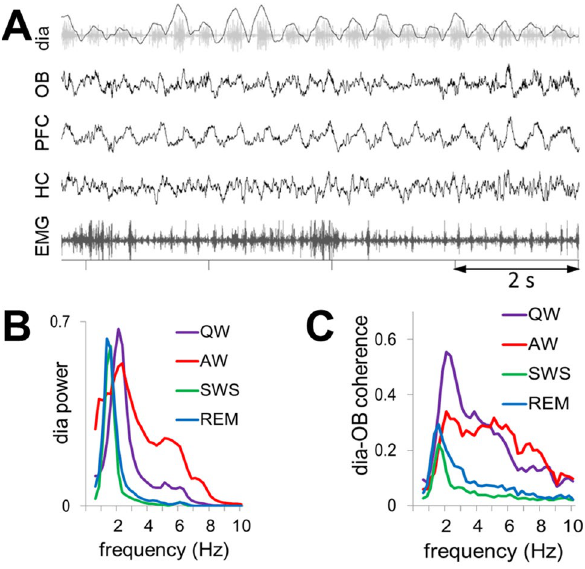
Figure 1. ( A) Sample recording of respiratory rhythm (black, inspiration up) derived from diaphragmal EMG (gray) along with LFPs in OB, PFC, and HC and neck muscle EMG in QW state. ( B) Group averages of dia autospectra in different states. Note narrow RRO peaks in all recordings at ~ 2 Hz. Power is shown in arbitrary units after normalization of autospectra in individual recordings setting maxima equal to 1. ( C) Group averages of dia-OB coherence spectra in different states. Note coherence peaks constrained to RRO frequencies (i.e. dia spectral peaks) in sleep and in a wider range, up to 6 Hz in wake states. In AW, dia-OB coherence does not have a clear RRO peak on the group average due to interindividual variability of the respiratory rates (see in Fig.